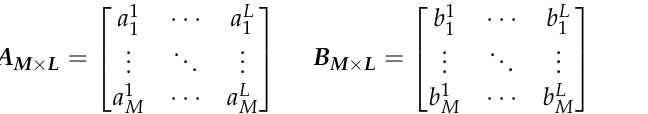
Figure 3. Transmitter of MC-ODBR-DCSK.